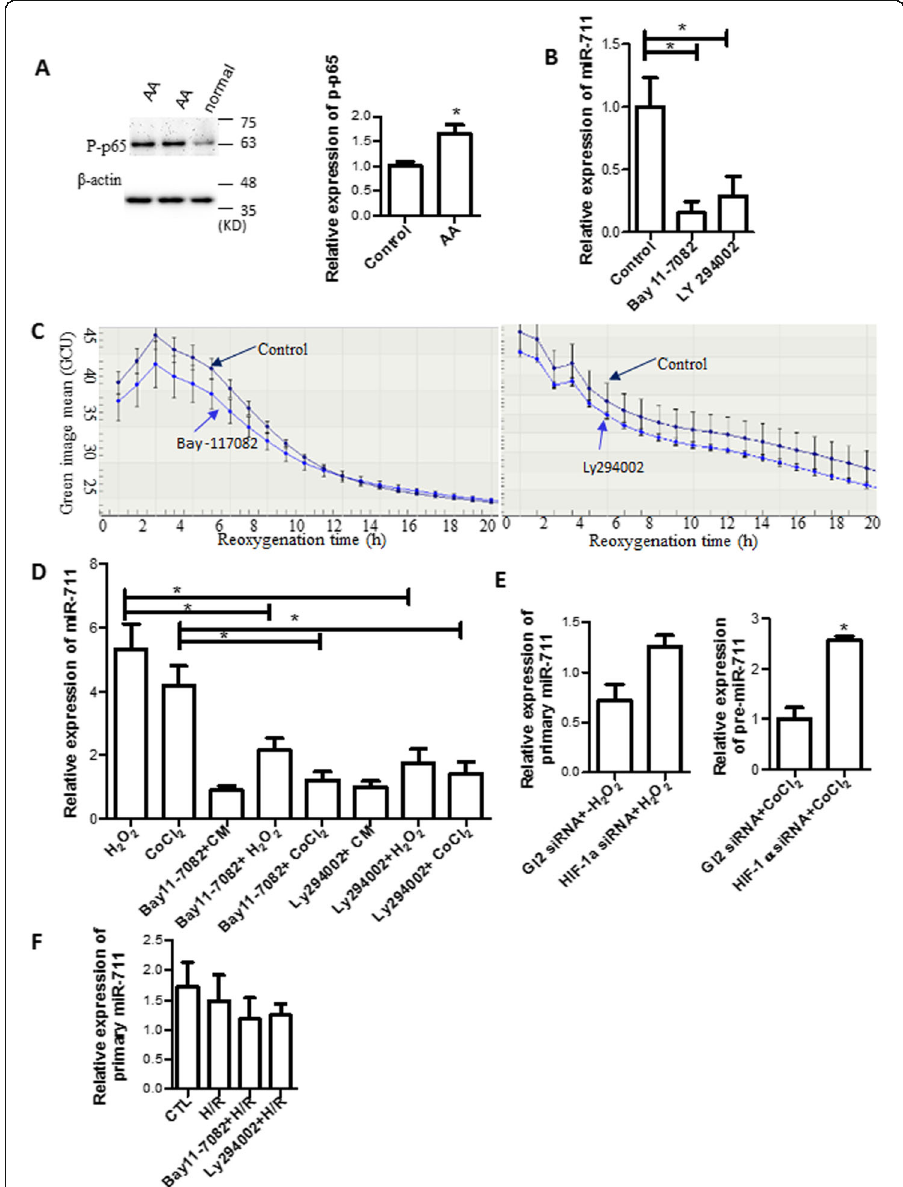
Fig. 6 NF К B regulated miR-711 expression a P-p65 expression. Total protein was extracted from cells treated with AA and p-p65 expression was determined by Western blotting. Left: Representative images of Western blotting: Right: semi-quantitative results of Western blotting. b Inhibition of the NF К B and PI3K pathways decreased miR-711 expression. Cells were treated with NF К B inhibitor Bay 11 – 7082 or PI3K inhibitor LY294002 for 1 h prior to cold H/R. miR-711 was detected by qRT-PCR. c Treatment with Bay 11 – 7082 and Ly 294002 reduced cell death. Cells were pre-treated with Bay 11 – 7082 and LY 294002 for 1 h and then treated with H 2 O 2 and CoCl 2 . Cell death was detected in an IncuCyte system as described in (5D). d Pretreatment with Bay 11 – 7082 and Ly 294002 reduced miR-711 induced by H 2 O 2 and CoCl 2 . Cells were treated as described in (6C). miR-711 was measured by qRT-PCR. e The effect of HIF-1 α siRNA on pre-miR- 711 expression. Cells were treated as described in ( b ). Pre-miR-711 was measured by qRT-PCR. f The effect of Bay 11 – 7082 and Ly 294002 on Pre-miR-711. Pre-miR-711 expression was measured by qRT-PCR. n = 3, * P <